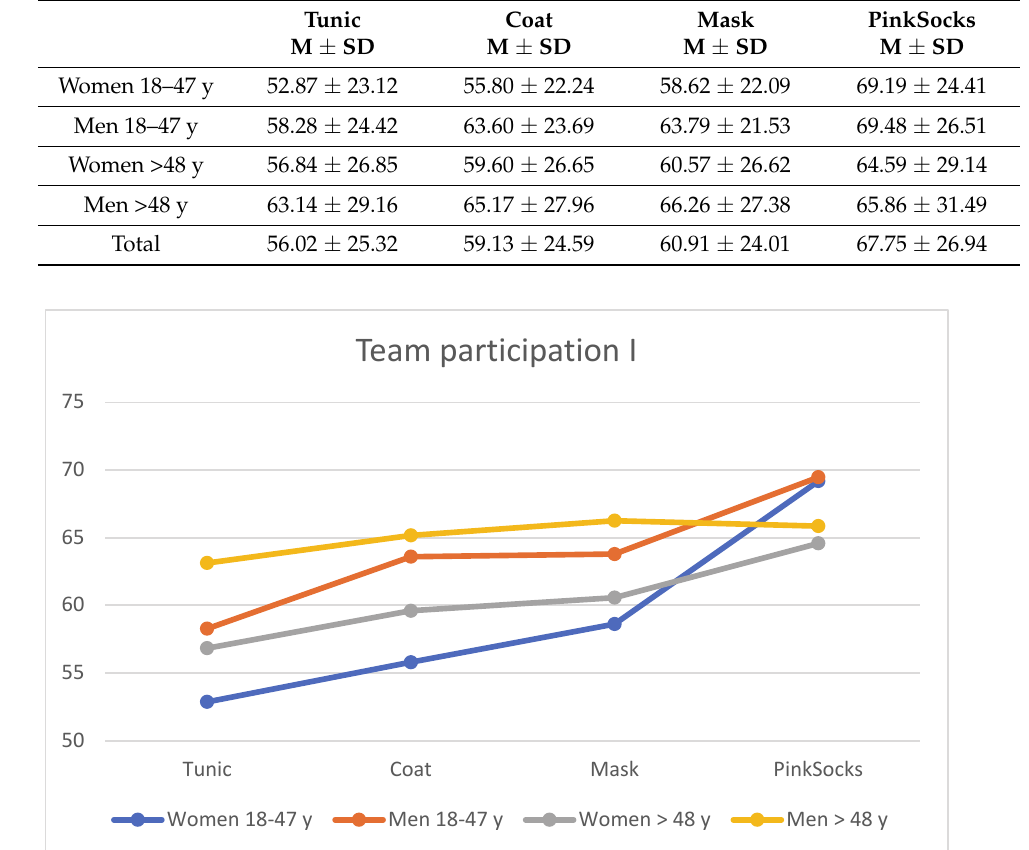
Figure 7. Mean rating of the four photos for team participation by the four subgroups ( n =